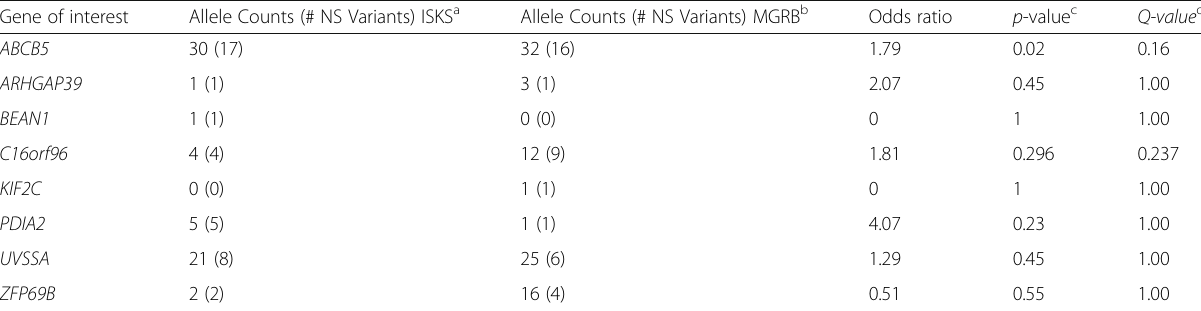
Table 4 Minor allele counts for rare nonsynonymous deleterious variants, odds ratios and p -values from Fisher ’ s exact test for genes of interest Gene of interest